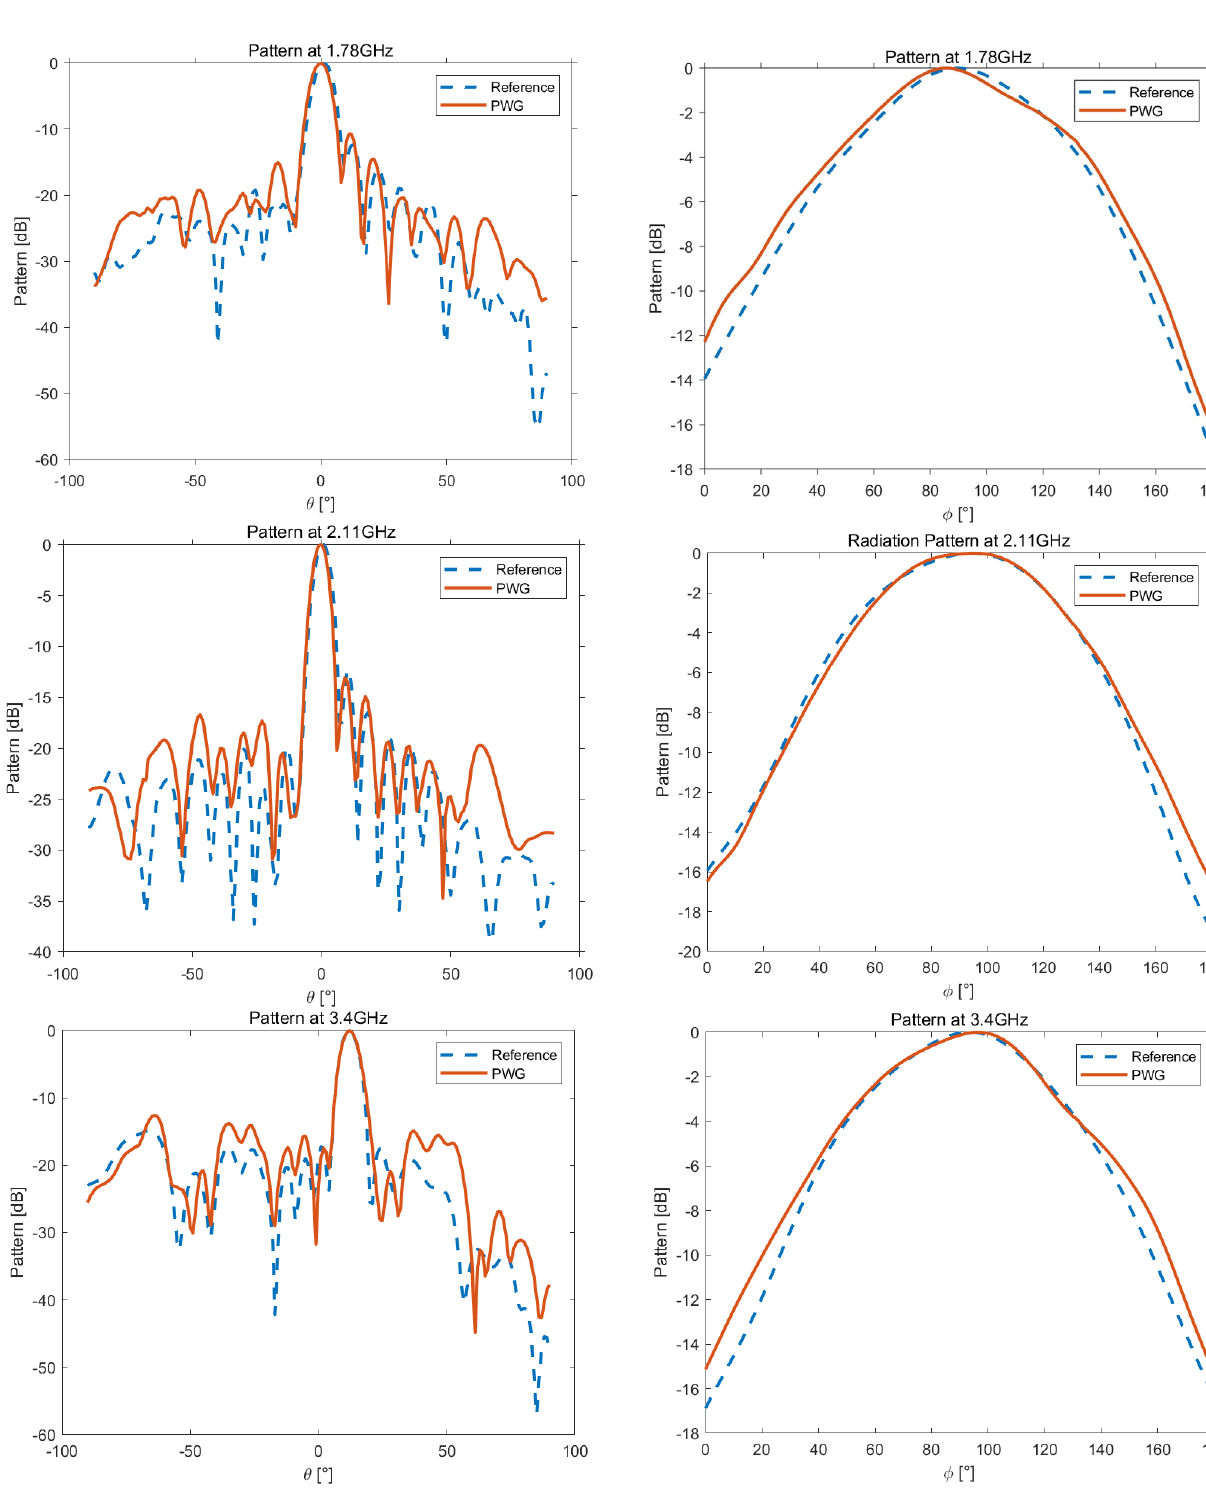
Figure 17. Base station radiation pattern test system.